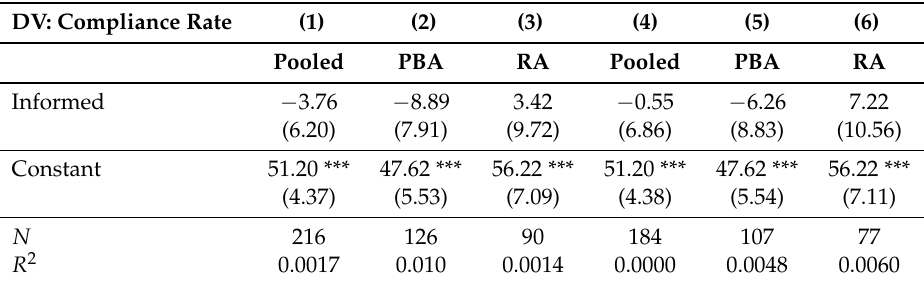
Table 3. Information treatment regressions